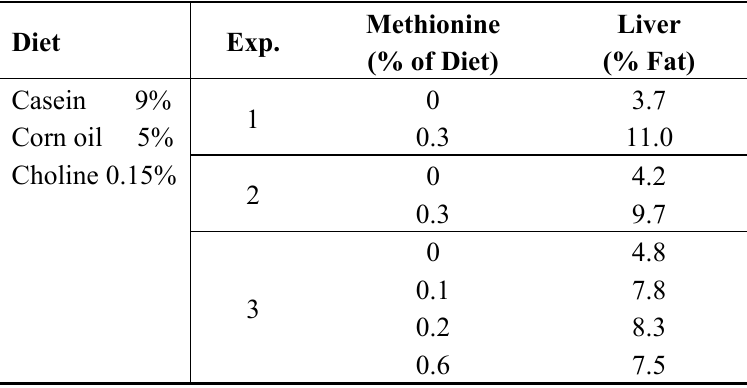
Table 7. Antilipotropic Effect of Methionine (from